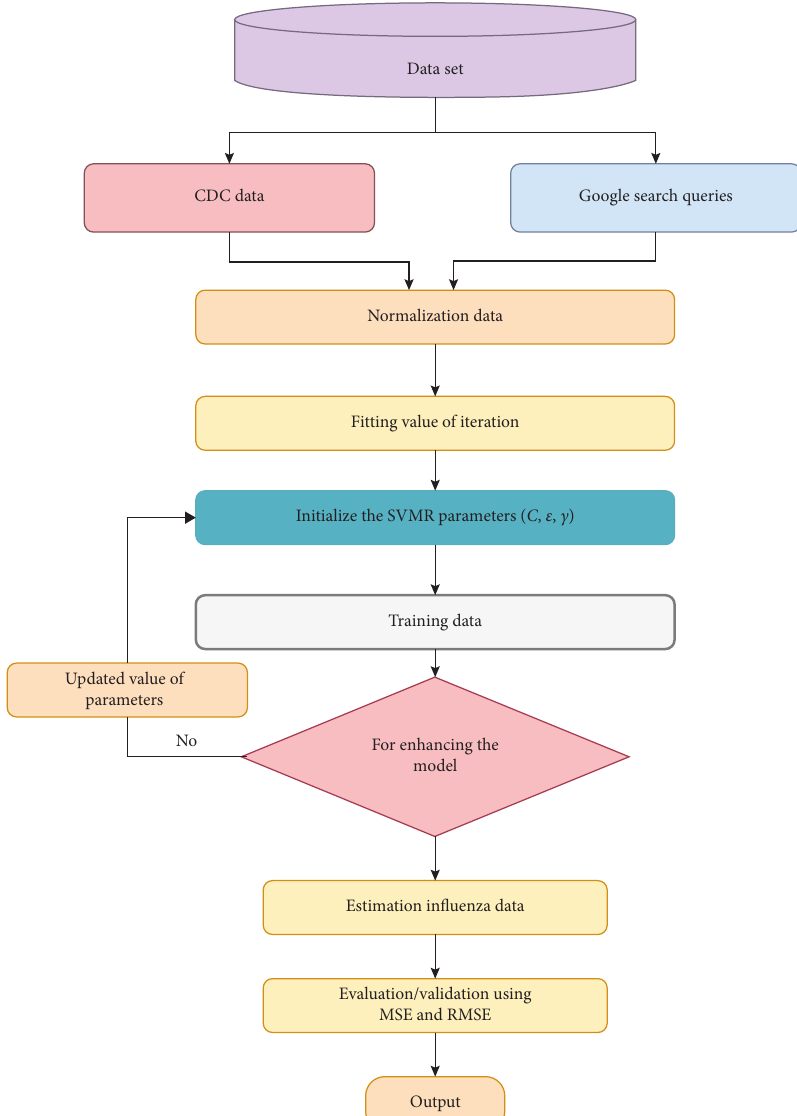
Figure 4: SVMR model is used to predict the influenza